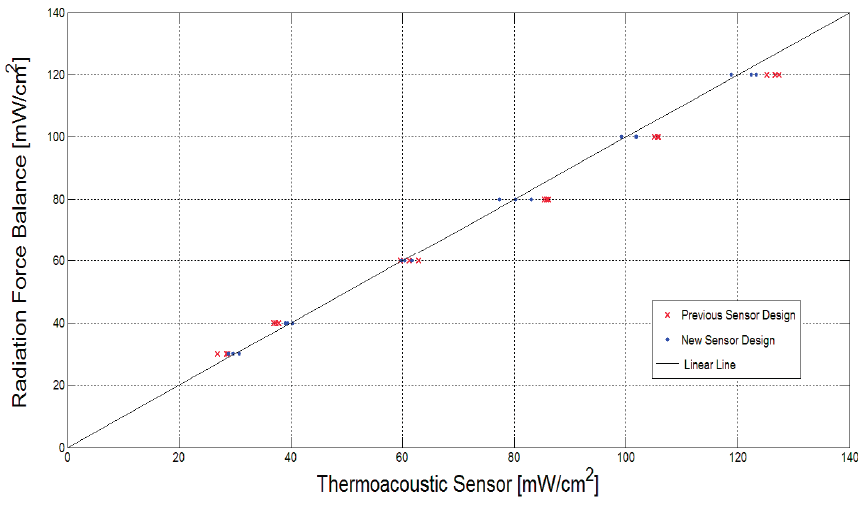
Figure 14. Comparison of the new sensors design measurements with that of the radiation force balance as a means to conduct a performance